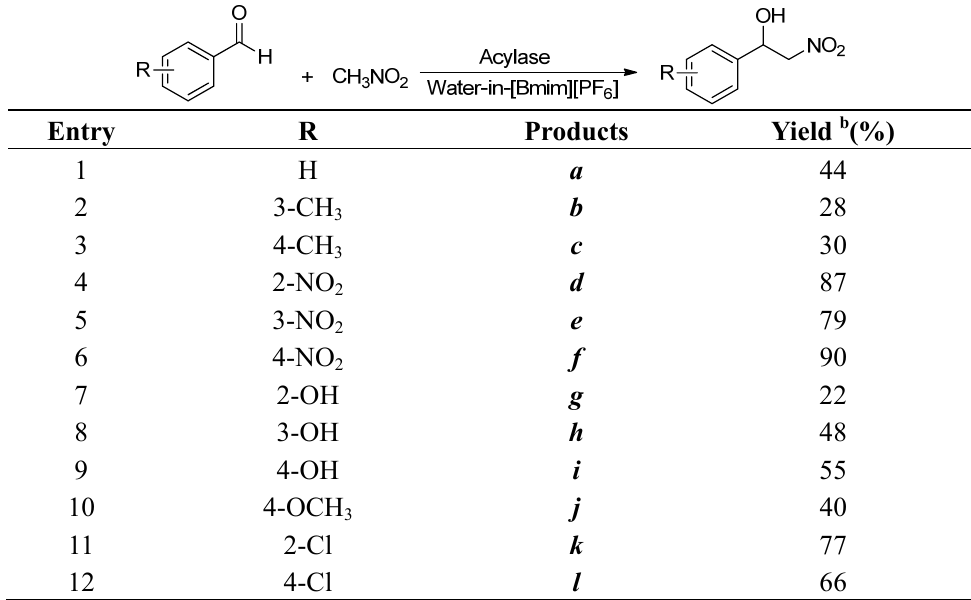
Table 3. Investigation of the reactant scope of the Henry reaction in IL-based microemulsions a